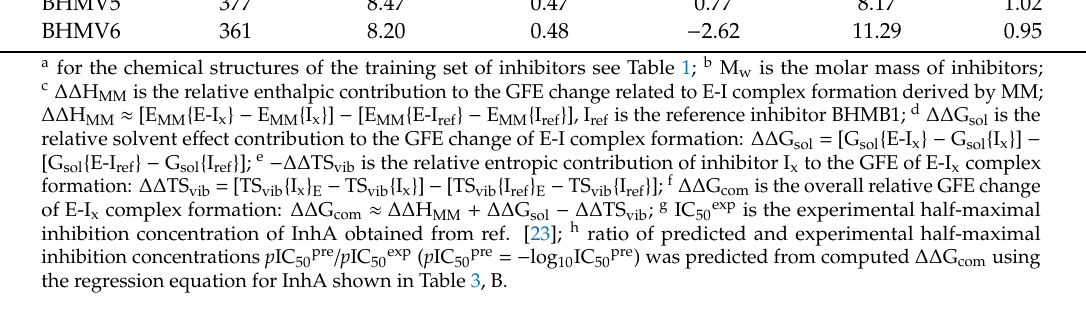
Table 3. Analysis of computed binding affinities ∆∆ G com , its enthalpic component ∆∆ H MM , and